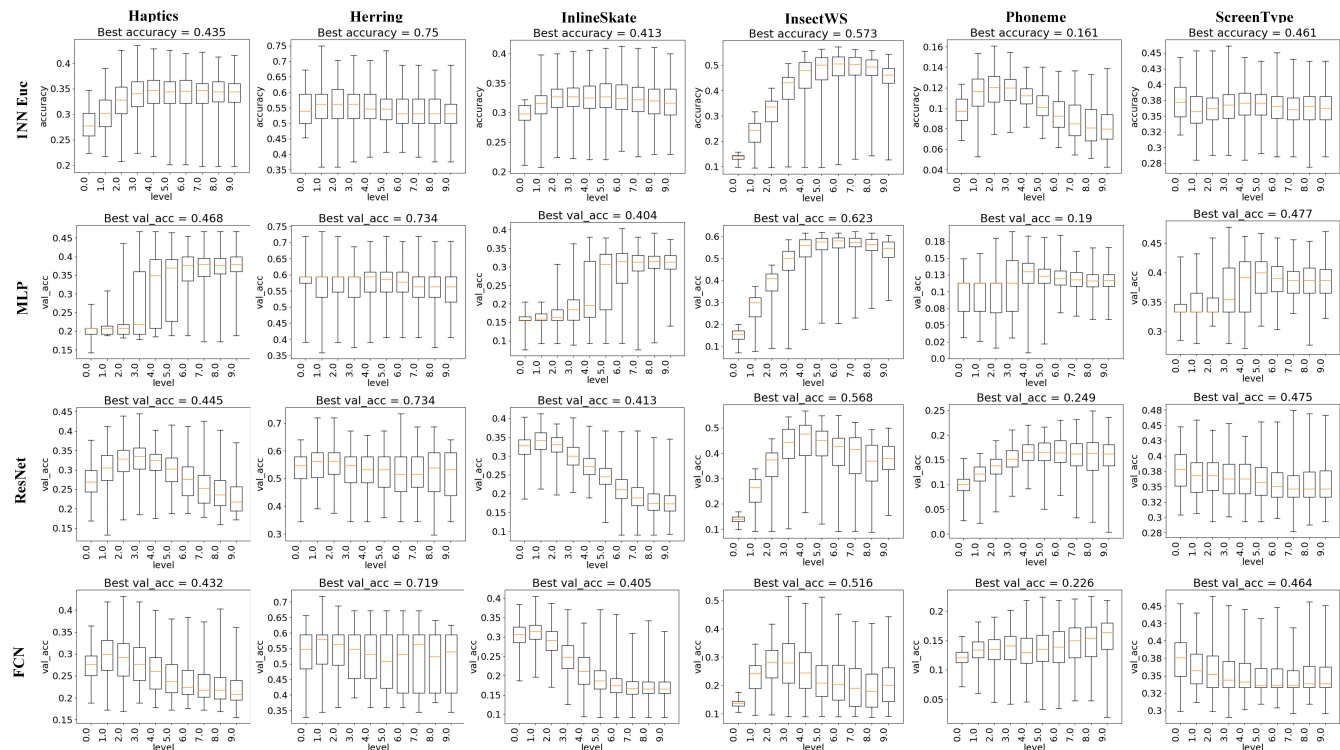
Figure 9. Impact of BDT level on TSC